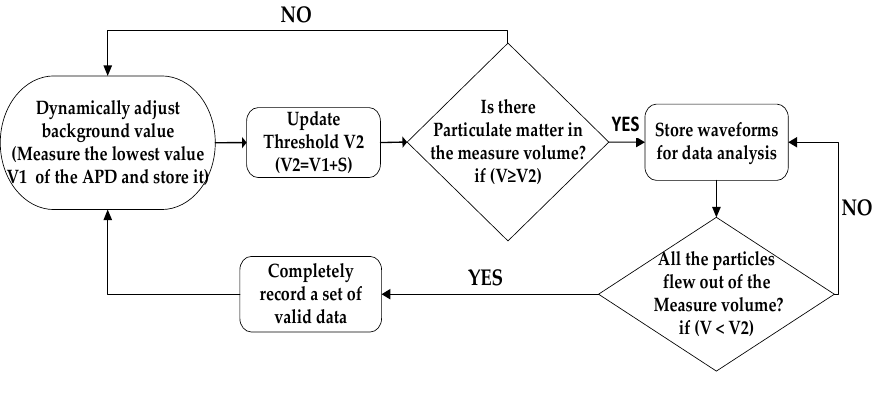
Figure 6. Processing flow of signal acquisition and storage. It is easy to process the waveforms of event 3 using digital processing techniques. Event 3 is called particle overlap. There are many ways to handle event 3. This paper proposed an anti-overlap algorithm, which can be achieved using the data processing flow shown in Figure